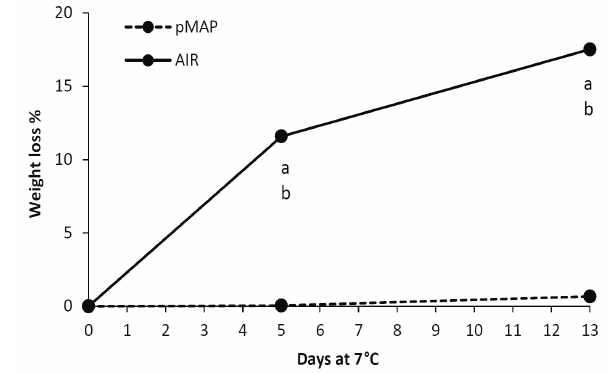
Fig. 3 ­ Weight loss of goji berries stored in pMAP or AIR for 13 days at 7°C (±1). Values are means of three replicates for each packaging condition at each storage time. Within the same storage time, different letters indicate statisti­ cal differences, P≤0.05.